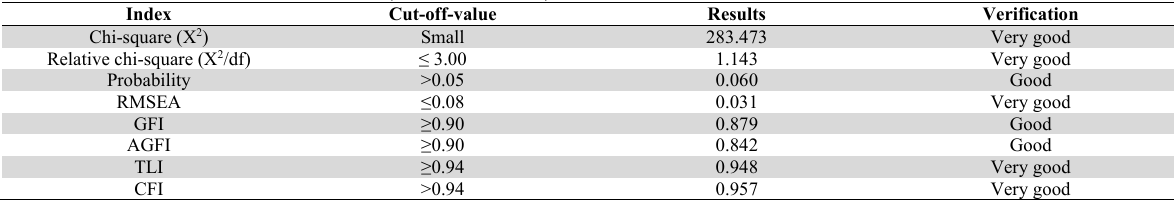
Evaluation of Modified Goodness of Fit (Model Revision)